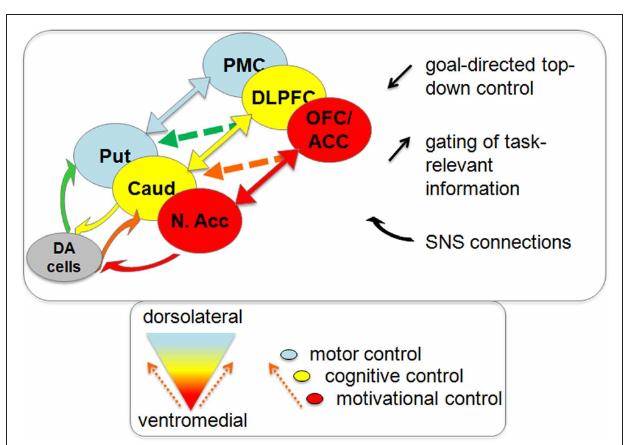
Figure 1 | Ventromedial to dorsolateral direction of information flow through frontostriatal-nigral circuitry. Interactions between the different frontostriatal loops involved in motivational control (red), cognitive control (yellow), and motor control (blue) can take place at the level of the SNS connections (bend arrows) or at the level of the frontostriatal connections (straight arrows). The direction of information flow is always from ventromedial to dorsolateral regions in the frontostriatal circuitry. SNS, striato-nigral-striatal; N. Acc, nucleus accumbens (ventromedial striatum); Caud, caudate nucleus (dorsomedial striatum); Put, putamen (dorsolateral striatum); OFC, orbitofrontal cortex; ACC, anterior cingulate cortex; DLPFC, dorsolateral prefrontal cortex; PMC,